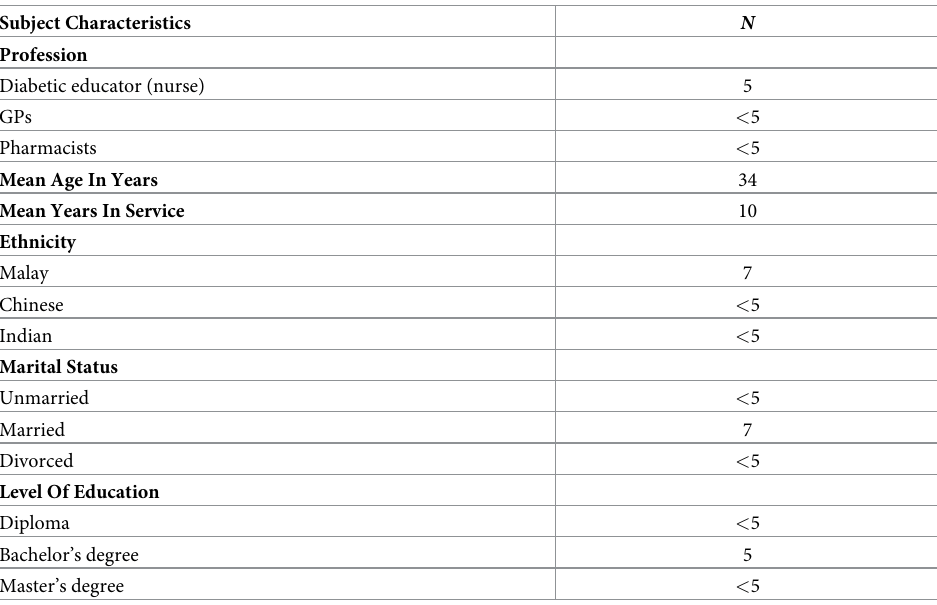
Table 2. Demographic details of healthcare professionals involved in the